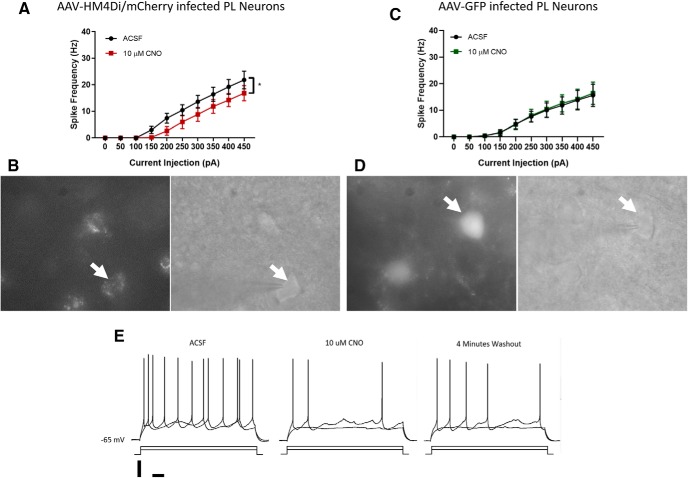
A, Excitability curve shows spikes elicited to progressively larger current injection of DREADDs-mCherry-expressing PL pyramidal cells before and after CNO (10 μM) exposure. B, Example image of DREADDs-mCherry-expressing PL pyramidal cell in fluorescent (left) and infrared (right). C, Excitability curve shows spikes elicited to progressively larger current injection of GFP-expressing PL pyramidal cells before and after CNO (10 μM) exposure. D, Example image of GFP-expressing PL pyramidal cell in fluorescent (left) and infrared (right). E, Example trace of DREADDs-expressing PL neuron; 4 min of CNO exposure caused a reduction in spike frequency to current injection compared to baseline, while removal of CNO from the bath caused a partial recovery of spike frequency. Scale bars = 20 mV and 100 ms, and stimulation was 250 and 350 pA for 1 s.